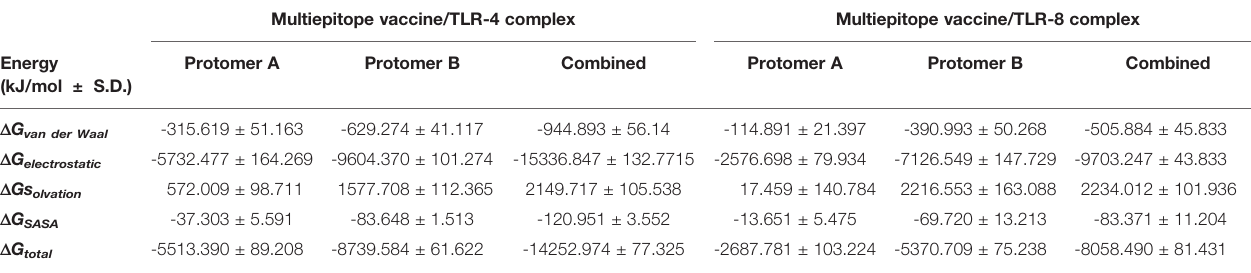
TABLE 5 | Free energies of binding and their individual energy contribution terms for multiepitope vaccine/TLR complexes. Multiepitope vaccine/TLR-4 complex Multiepitope vaccine/TLR-8 complex Energy (kJ/mol ±